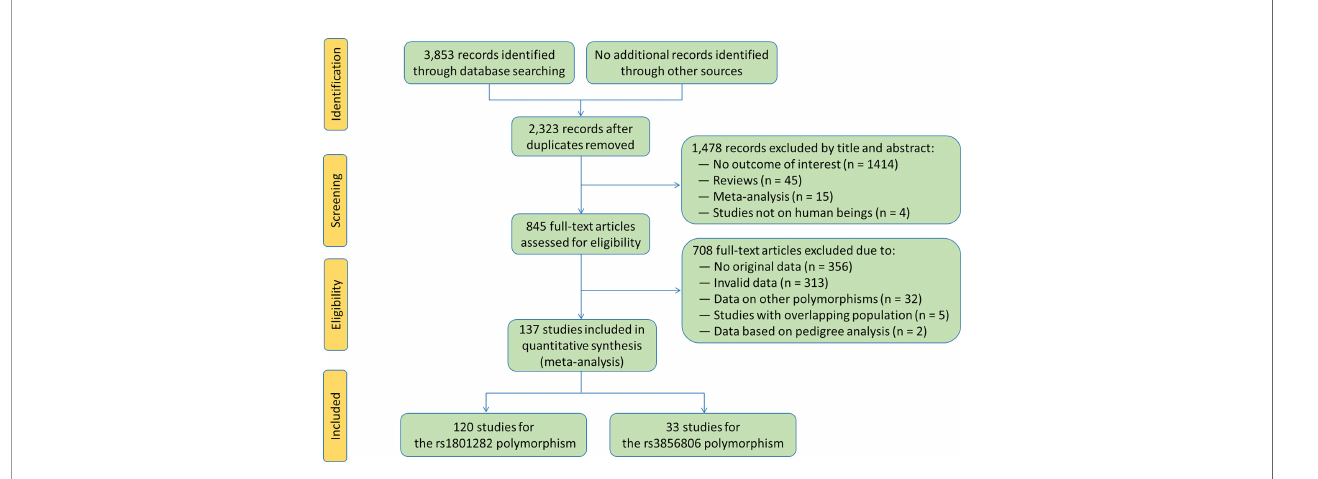
FIGURE 2 | Flow chart of the literature selection in